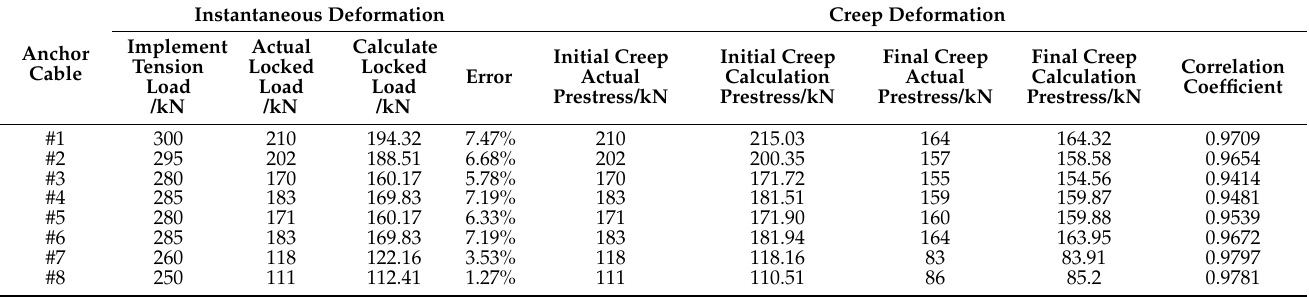
Table 5. Comparison of the monitoring and model calculation results for the prestress of the